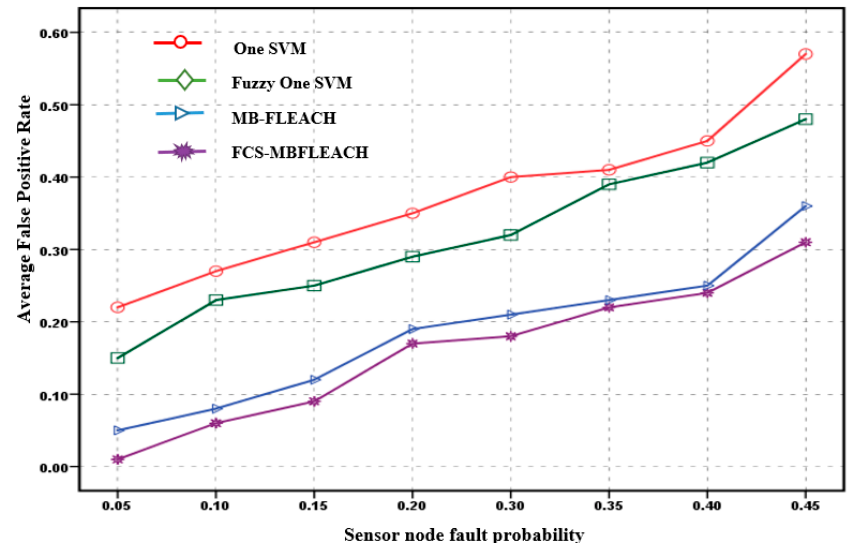
Figure 12. The average false positive rate for sensor node faults with a density equal to 10 for the first scenario.